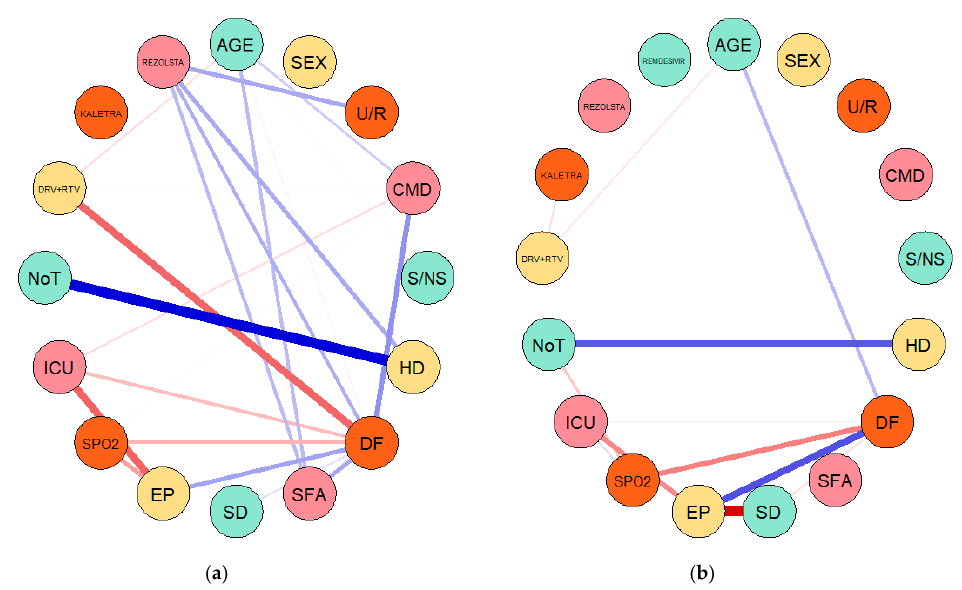
Figure 3. GGMs configuration through the EBIC with graphical lasso method and the associated results: ( a ) first sample of 145 COVID-19 patients from the first wave of infection; ( b ) second sample of 129 COVID-19 patients from the second wave of infection. Source: Own configuration in RStudio version 3.6.3.